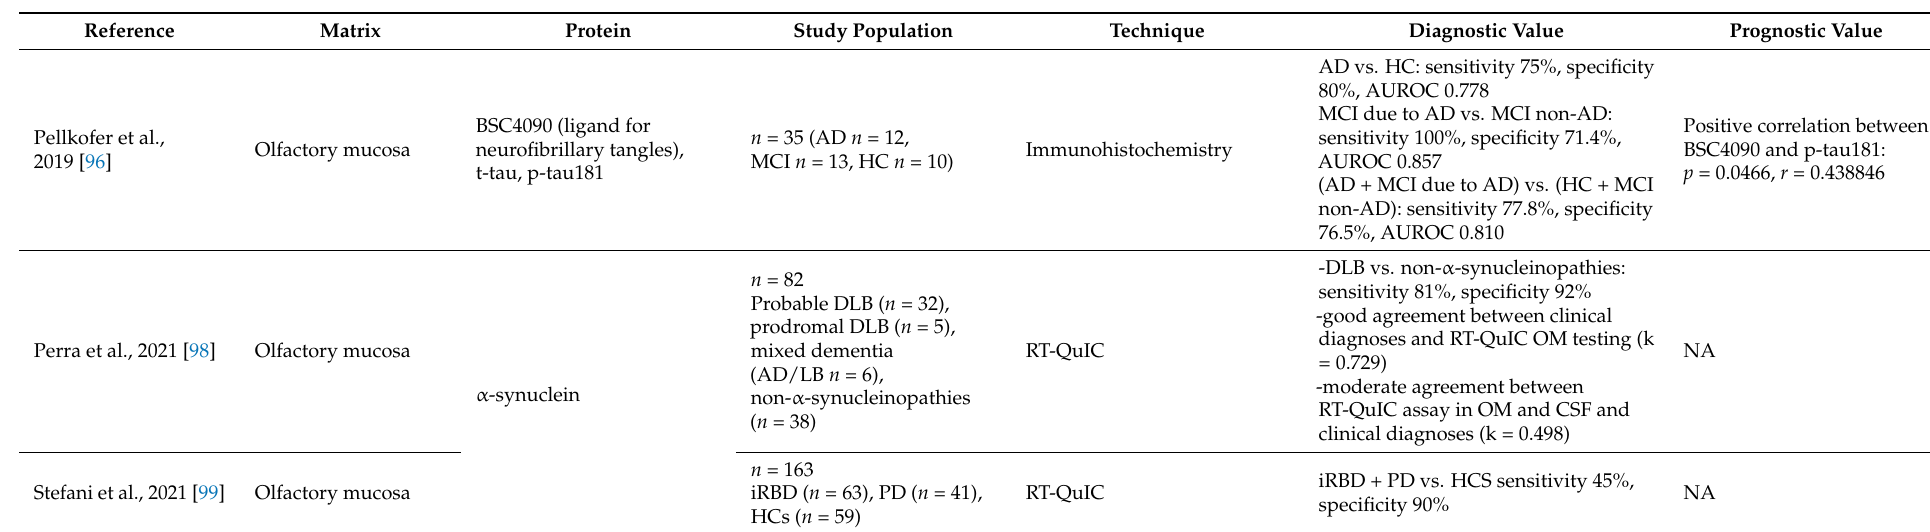
Table 2. Biomarkers in olfactory mucosa in the work-up of